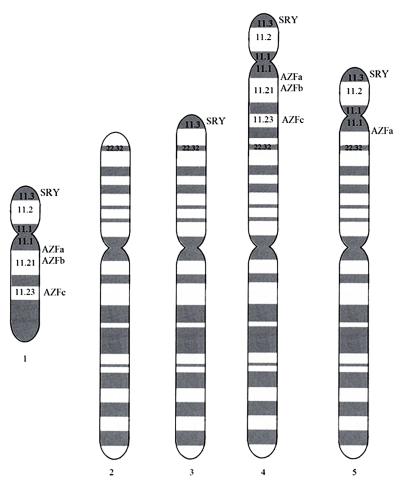
1 - Normal Y Chromosome; 2 - Normal X Chromosome; 3 - Derivative X Chromosome of cases number 1, 3-8, and 10; 4 - Derivative X Chromosome of case 2; 5 - Derivative X Chromosome of case